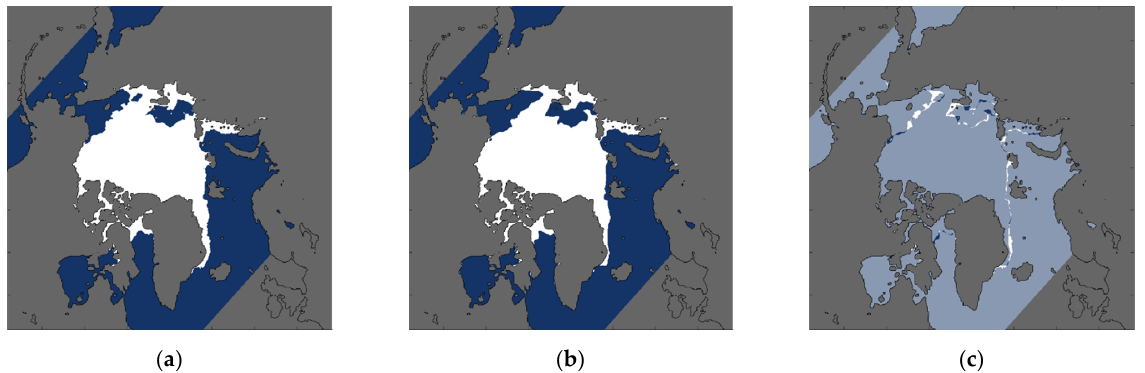
Figure 11. SIE Arctic composites using MWR data from 3 November. ( a ) FMPL-2 MWR map, ( b ) Ground truth map, ( c ) Error map.